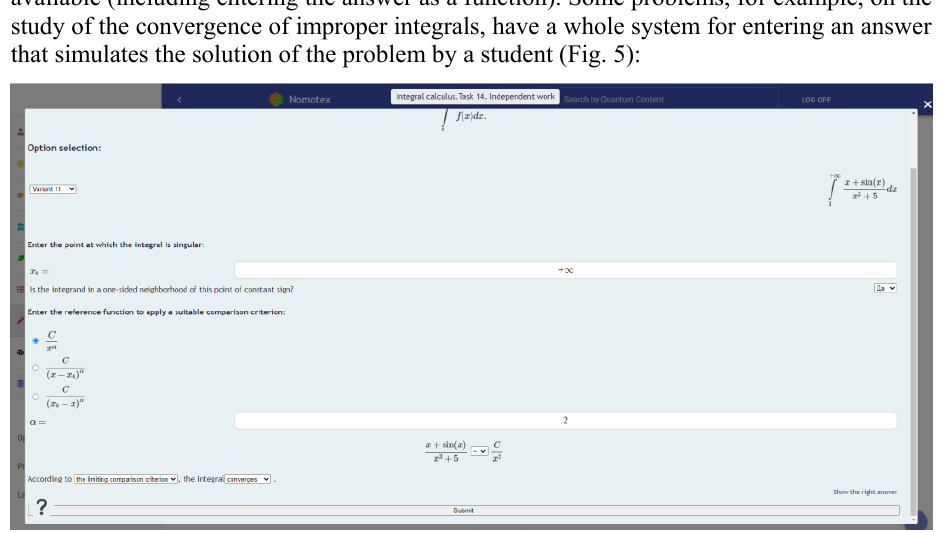
Fig. 5. Entering the answer in the DLS “Nomotex”.